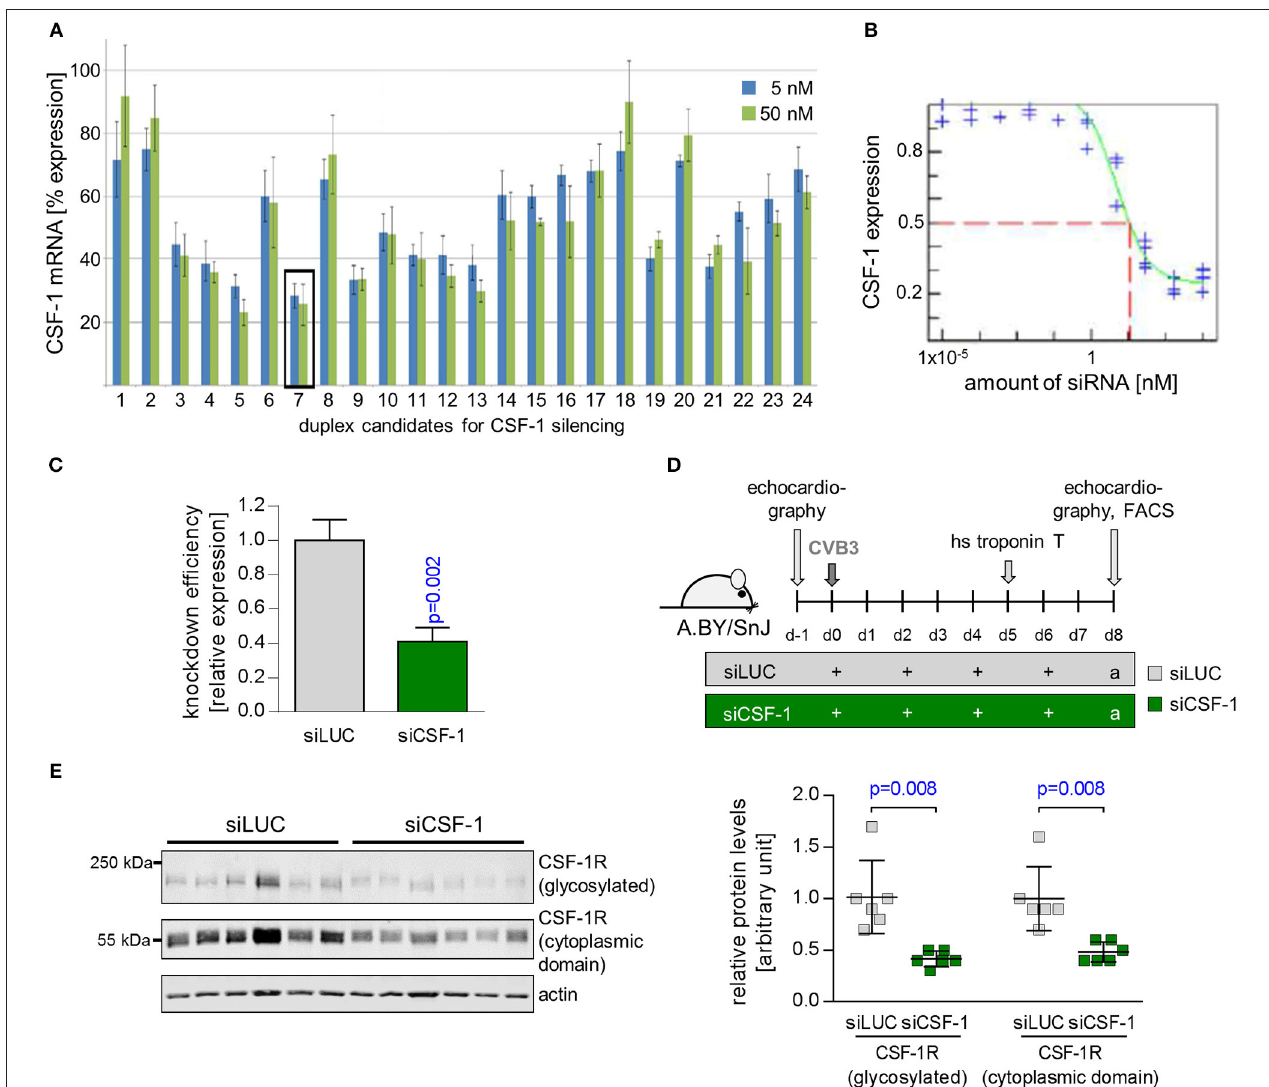
FIGURE 3 | Suppression of CSF-1 production by siRNA-encapsulated nanoparticles. (A) NIH-3T3 cells were transfected with 24 siRNA candidates directed against CSF-1. siRNA #7 was most efficient to reduce CSF-1 mRNA expression both at 5 and 50nM and was selected for further studies. (B) CSF-1-directed siRNA # 7 was titrated and the respective CSF-1 knockdown efficacy was determined. (C) Knockdown efficacy of nanoparticle-encapsulated CSF-1 candidate siRNA pool 7 after injection into naive Balb/c mice ( n = 3). (D) A.BY/SnJ mice were intravenously treated with nanoparticle encapsulated siRNA targeting either luciferase ( n = 7 siLUC, gray color) or CSF-1 siRNA #7 ( n = 8 siCSF-1, green color) directly prior to CVB3 inoculation. siRNA treatment was repeated after 2, 4, and 6 days. (E) The overall efficacy of siCSF-1 treatment during AVM as indicated by the presence of CSF-1-R)-positive cells was monitored by Western blot analysis of spleen tissue homogenates ( n = 6 mice per group) 8 day after virus inoculation. CSF-1R (high molecular weight band) and the cytoplasmic domain of CSF-1R (around 55 kDa) are depicted. Fluorescence was quantified by the Image Studio Lite Ver 5.2 software. Signal intensity was normalized to actin and is depicted as relative expression levels compared to siLUC-treated mice in the bar graph. Unpaired t- tests were used; p -values are indicated on the graph and significant differences ( p < 0.05) are marked with blue